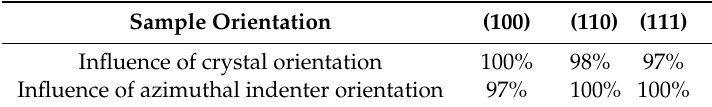
Figure 2. Optical images of pile-up patterns ( 𝐹 (cid:3040)(cid:3028)(cid:3051) = 60 mN) on three crystallographic orientations of aluminum single crystals (aligned patterns, ( a ): (100), ( b ): (110), ( c ): (111)). Indents on the same surfaces azimuthally rotated by 45° (misaligned patterns, ( d ): (100), ( e ): (110), ( f ): (111)). 4.2. Pile-up and Sink-in Corrections Figure 3 depicts a (100)-oriented sample. In it, 𝐴 (cid:3043) (solid line) is smaller than 𝐴 (cid:3030) (dashed line) which leads to an 𝛼 -factor less than 1. The overall results for the 𝛼 -factor (Figure 4) confirm this trend ( 𝐴 (cid:3043) (cid:3407) 𝐴 (cid:3030) ) for all indenter–sample configurations. Furthermore, 𝛼 seems to be dependent on the indenter orientation for the crystal orientation (100) and (110). No such dependency is observed for the (111) orientation.